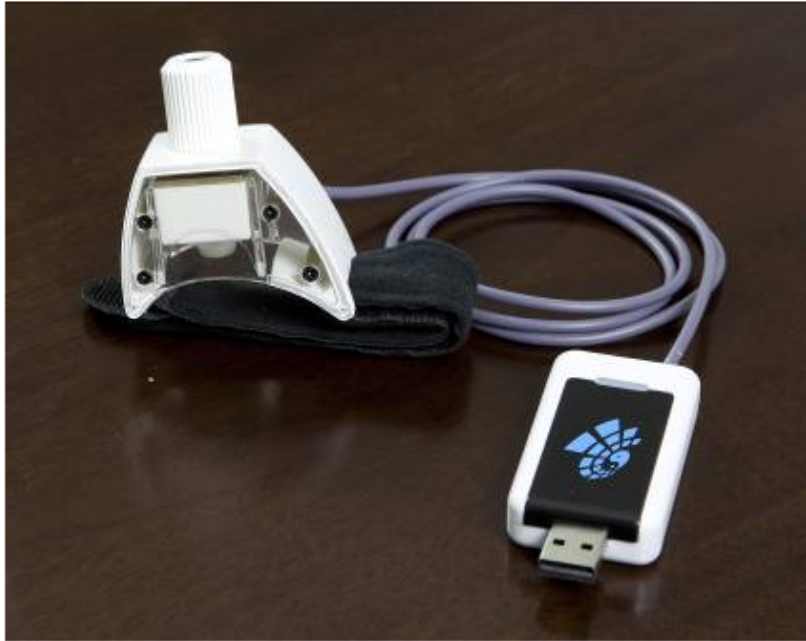
Figure 1. Traditional Chinese medicine pulse life informatics analysis